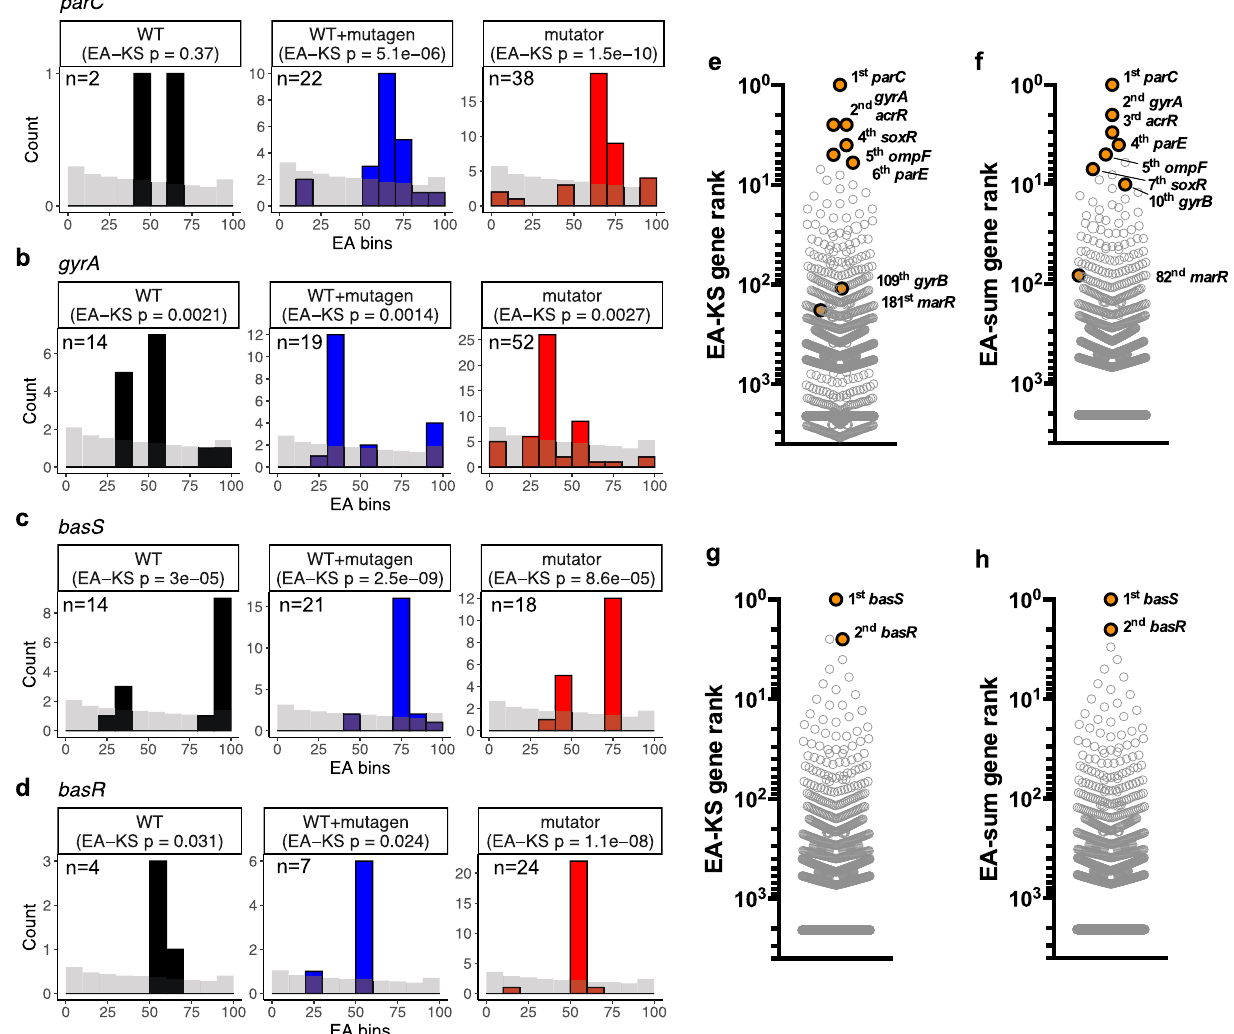
Fig. 2 Known drivers of resistance have non-random EA integrals and are frequently mutated across cultures. a – d The EA distributions of known drivers parC, gyrA, basS or basR mutations compared to randomly simulated mutations (gray bars, 63,507 randomly simulated coding mutations) with results of one-sided Kolmogorov-Smirnov (KS) test shown. The number of mutations observed in each gene and mutational conditions are label in the fi gure. For visual comparison, the simulated mutations bars were scaled to the mutation count observed for each gene in each mutation load. The parC and gyrA pro fi les are from the cipro fl oxacin dataset while basS and basR are from the colistin dataset. Black, MG1655; Blue, MG1655 + nucleotide analogs; Red, mutator strain. e – h The combined rankings are plotted for cipro fl oxacin or colistin datasets using either a KS test (EA-KS) or the mutation rate adjusted summation of EA scores (EA-sum). Genes previously shown to contribute towards either cipro fl oxacin resistance ( e , f ) or colistin resistance ( g , h ) are shown in orange and labeled with rank. Source data are provided as a Source Data fi